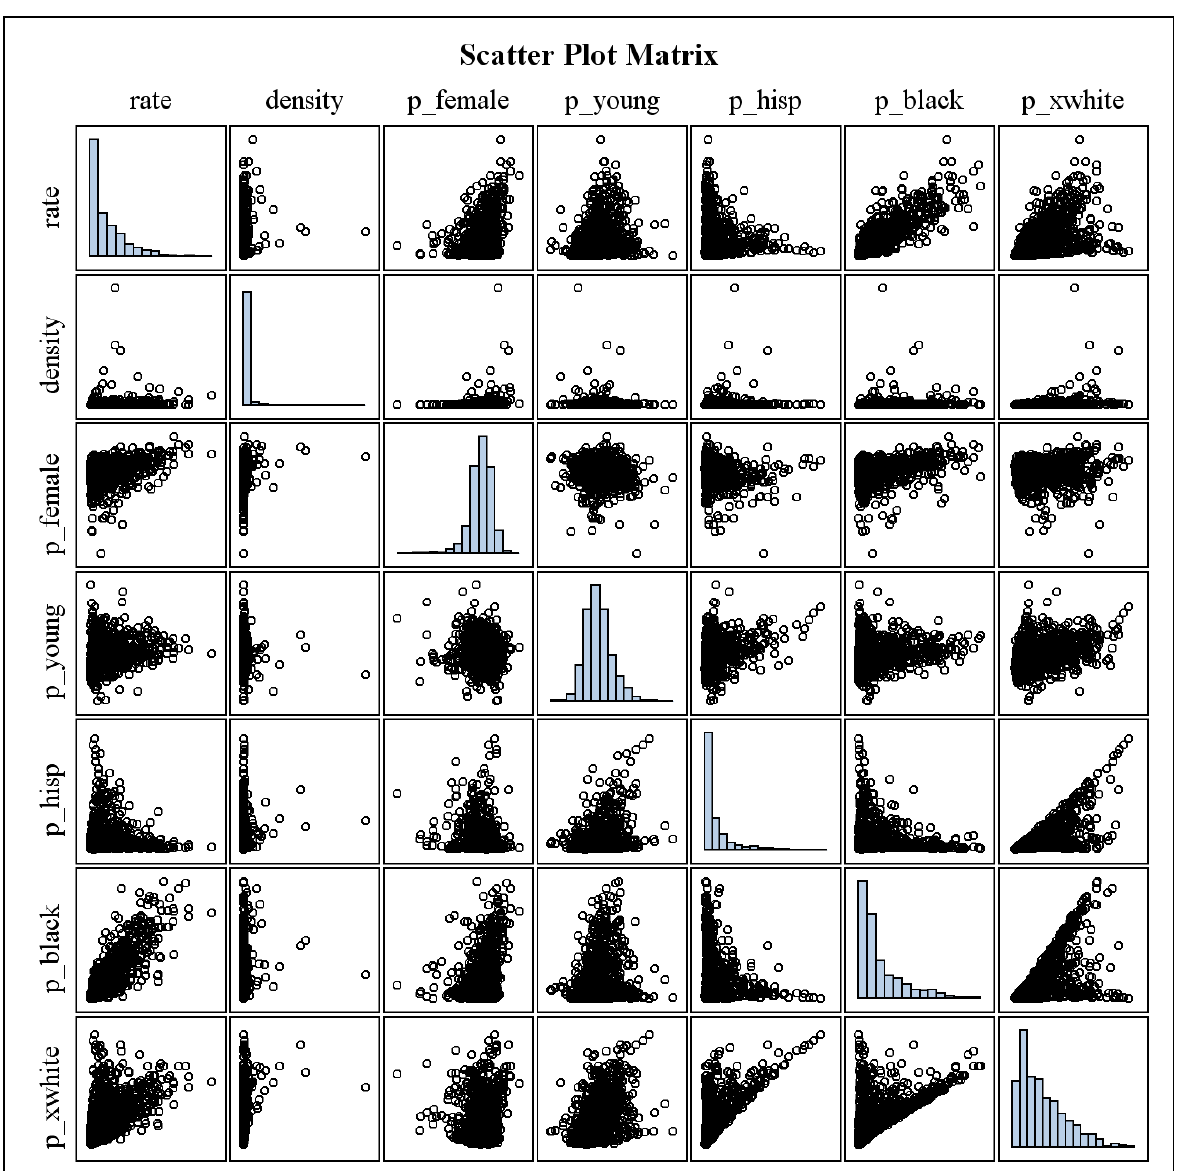
Figure 1. Histograms and scatter plots of the gonorrhea diagnosis rates and both SDH and demographic variables using the original variables (without log transformation): National Notifiable STD Surveillance and American Community Survey data,